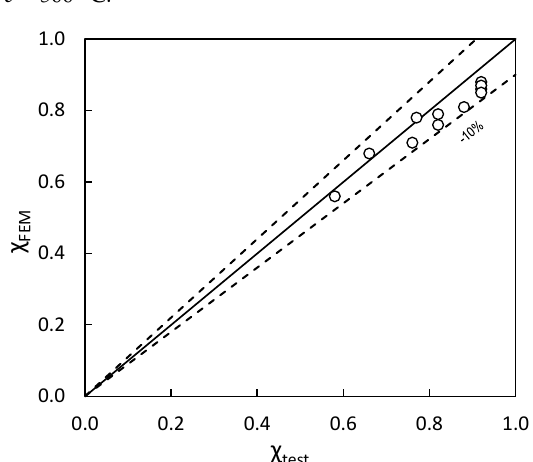
Figure 5. Validation of the numerical results against the test results. Table 3. Validation of the numerical results against the test series from ETHZ.